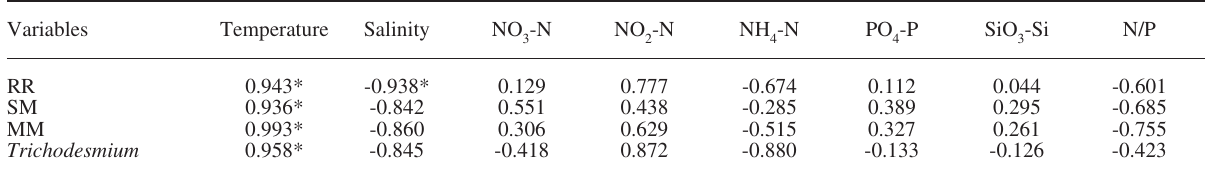
Table 6. – Pearson correlation coefficients between nitrogen fixations rates and environmental variables. RR= Reefs and rocky sediments; sM= seagrass and macroalgal communities; MM= Microbial mats. * P <0.05.